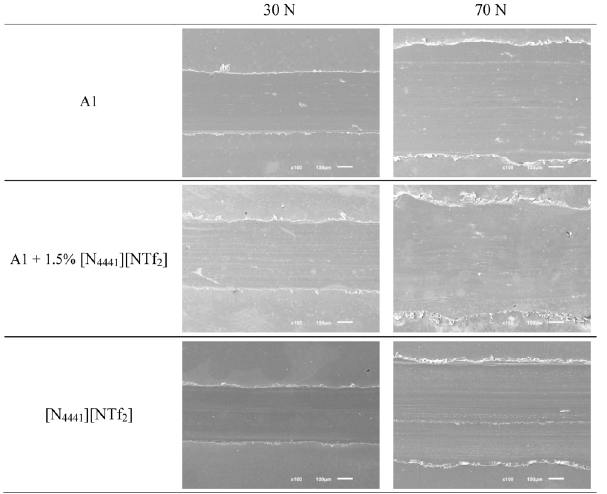
Fig. 5 SEM images from the wear scar of test made at room temperature.